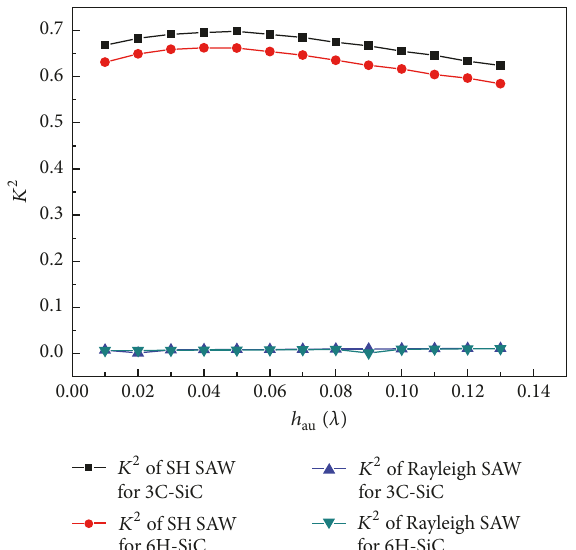
Figure 8: Comparison of 𝐾 2 for SH and Rayleigh SAWs on YX-PIMNT/3C-SiC with YX-PIMNT/6H-SiC layered structure for various electrode thicknesses with ℎ PIMNT = 0.3𝜆 and 𝜃 = 90 ∘